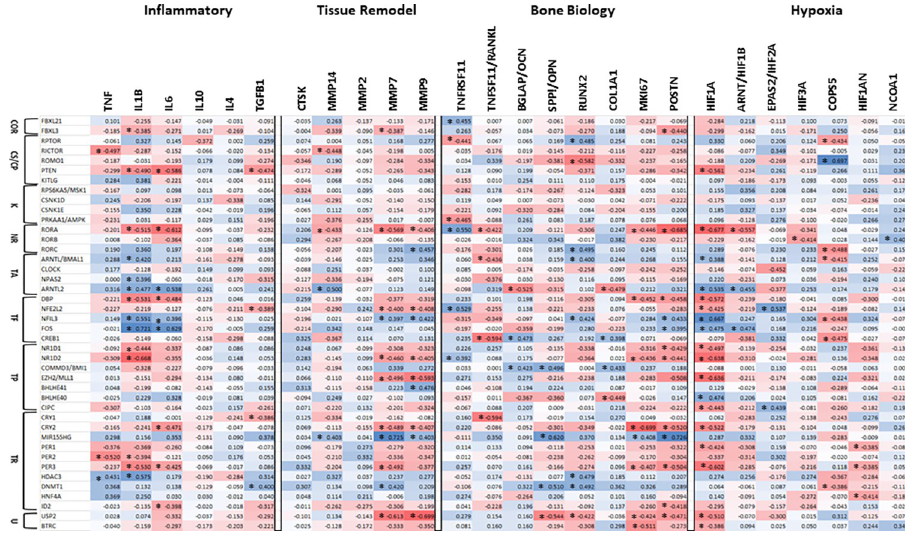
Fig 3. Heatmap of circadian rhythm pathway gene expression profiles correlated with inflammatory genes, tissue destructive/remodeling genes, bone biology genes, and hypoxia genes in gingival tissues from healthy and naturally-occurring periodontitis sites across all age groups. Functional designation of the genes are as in Fig 1. Values denoted by asterisk ( � ) were significant at p < 0.01.